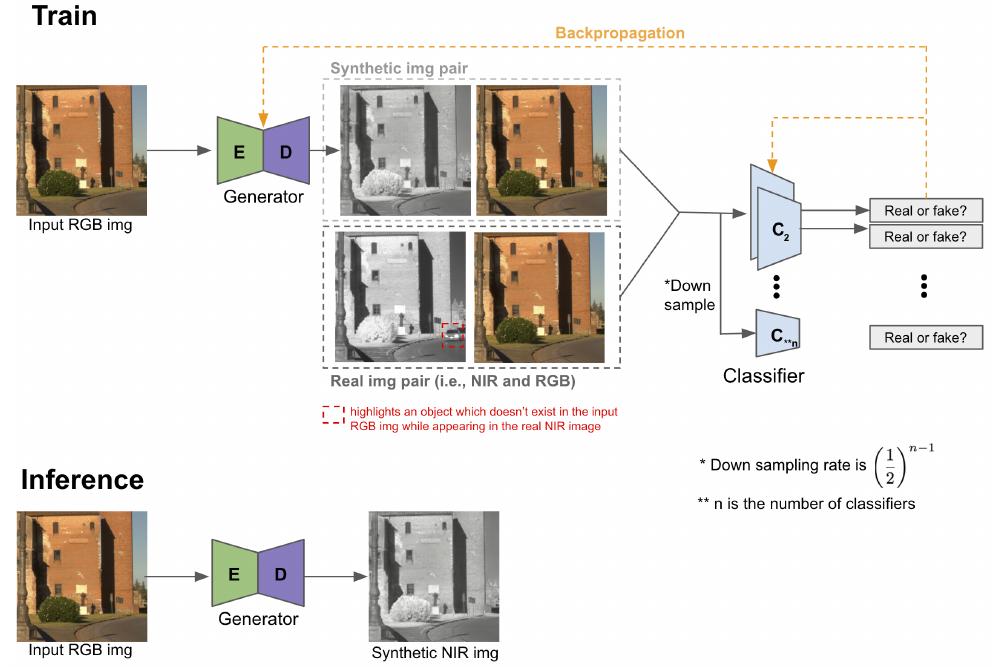
Figure 3. Synthetic image train ( top ) and inference ( bottom ) pipeline. This is one of typical type of conditional generative adversarial network (cGAN) [29]. Image redrawn from